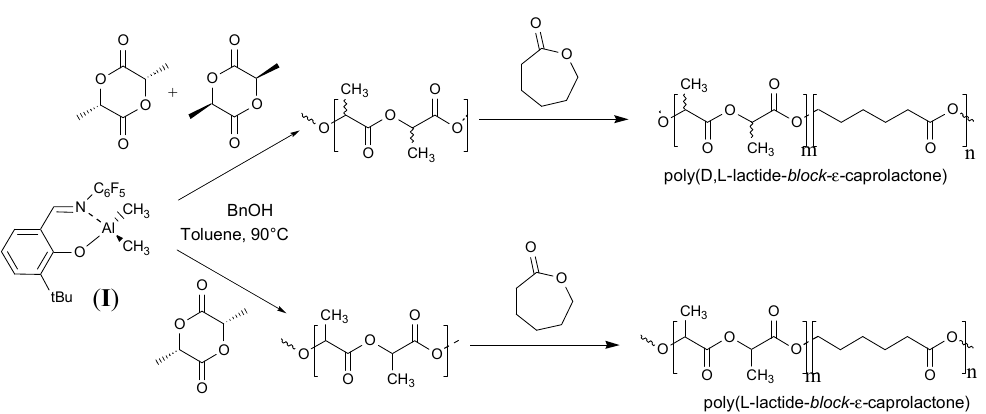
Scheme 1. Synthesis of LA/CL block